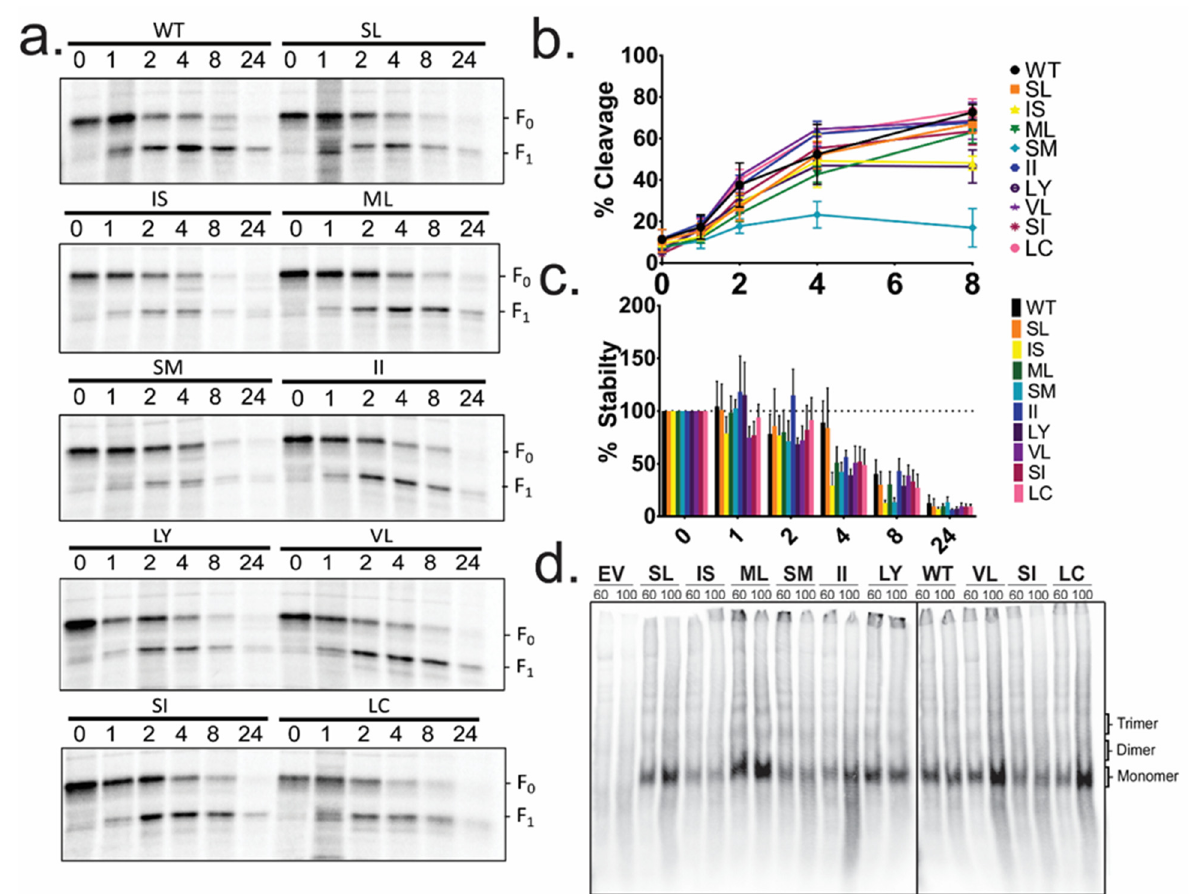
Figure 3. HeV F TM mutations at residues SM and LY decrease protein cleavage levels . ( a ) Vero cells were transfected with WT HeV F or the TM mutant DNA, metabolically labeled for one hour, and chased for times indicated (hours). Using band densitometry ( b ) percent cleavage and ( c ) percent stability were calculated. Graphs are shown as the average of three independent experiments ± SEM. ( d ) Vero cells transiently expressing empty vector (EV), WT F (WT), or each TM mutant were metabolically labeled for 6 h. Samples were treated at the indicated temperatures before separation on a non-reducing SDS-PAGE. Oligomers are labeled on the right based on size ( n = 3). Two gels were run under the same conditions to accommodate all samples. A black line is used to separate the lanes that were run on the second gel.